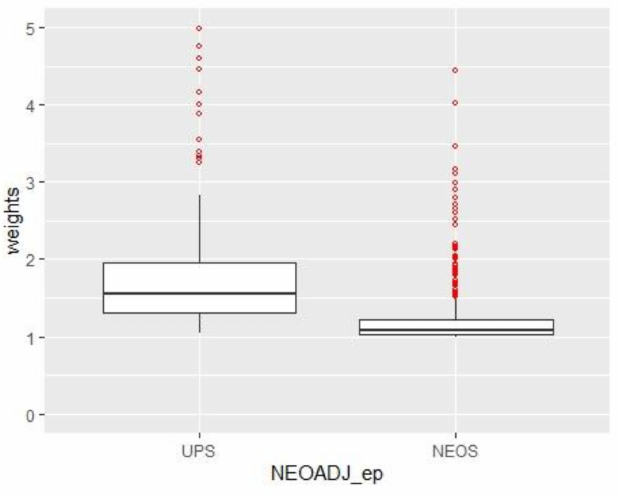
Figure 2. Boxplot with the distribution of the weights among the groups after the